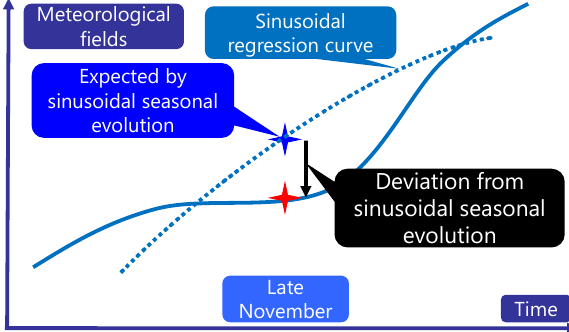
Figure 3. Schematic diagram of a late November deviation in the seasonal evolution of a climatological meteorological field. Blue cross mark indicates the values of the meteorological field in late November expected by sinusoidal seasonal evolution, and the red cross mark indicates its actual value in late November. The verti- cal difference between the actual value (red cross mark) and the expected value (blue cross mark) during late November, which is calculated by Eq. (4), is the field